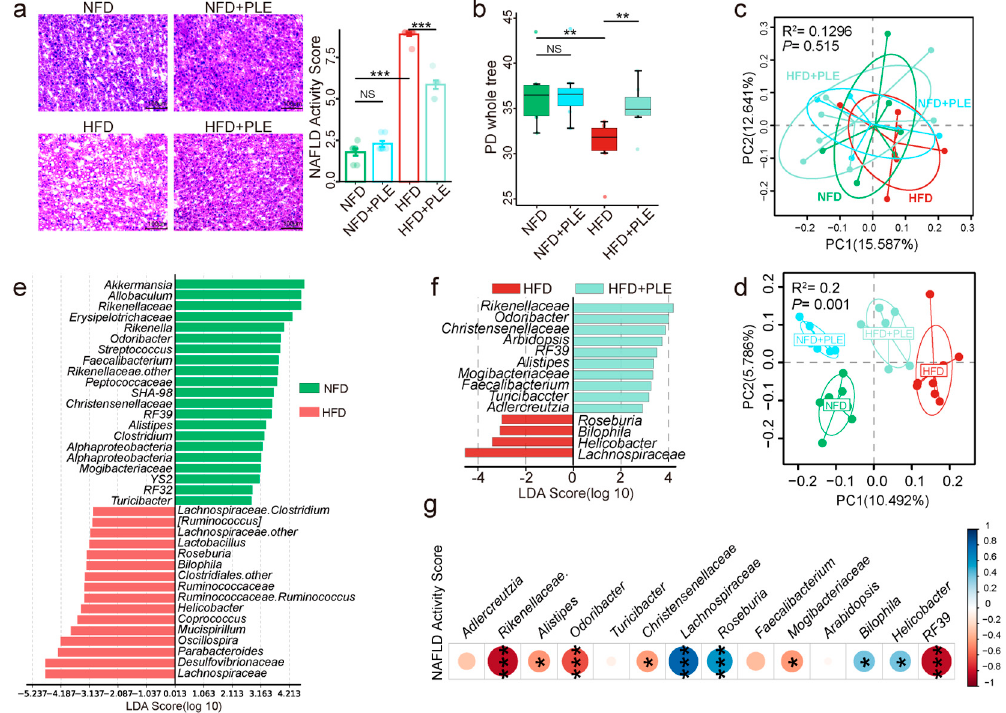
Figure 1. PLE prevents HFD-induced NAFLD associated with the gut microbiota. ( a ) Representative H&E images of the liver and NAS scores in each group (n = 7~9). ( b ) Comparison of alpha-diversity indices (PD whole tree index) in each group (n = 7~9). ( c ) Principal coordinate analysis (PCoA) plots of each group before treatment based on unweighted UniFrac distance matrices (n = 7~9). ( d ) PCoA plots of each group after treatment based on unweighted UniFrac distance matrices (n = 7~9). ( e ) Linear discriminant analysis effect size (LEfSe) analysis between the NFD and HFD groups (n = 7~9). ( f ) LEfSe analysis between the HFD and HFD+PLE groups (n = 7~9). ( g ) Correlation analysis of the abundances of genera in the gut microbiota with the NAFLD activity score. p values were calculated using the Wilcoxon rank-sum test and corrected by the method described by Benjamini and Hochberg, * p < 0.05, ** p < 0.01 and *** p < 0.01 indicate a significant difference between the two corresponding groups. NFD: treatment with a normal-fat diet; HFD: treatment with a high-fat diet; NFD+PLE: treatment with a normal-fat diet and 150 mg/kg polyphenol-rich Liupao tea extract; HFD+PLE: treatment with a high-fat diet and 150 mg/kg polyphenol-rich Liupao tea extract. Table 2. Tentative LC ‒ MS identification of the small molecules from polyphenol-rich Liupao extract (PLE).